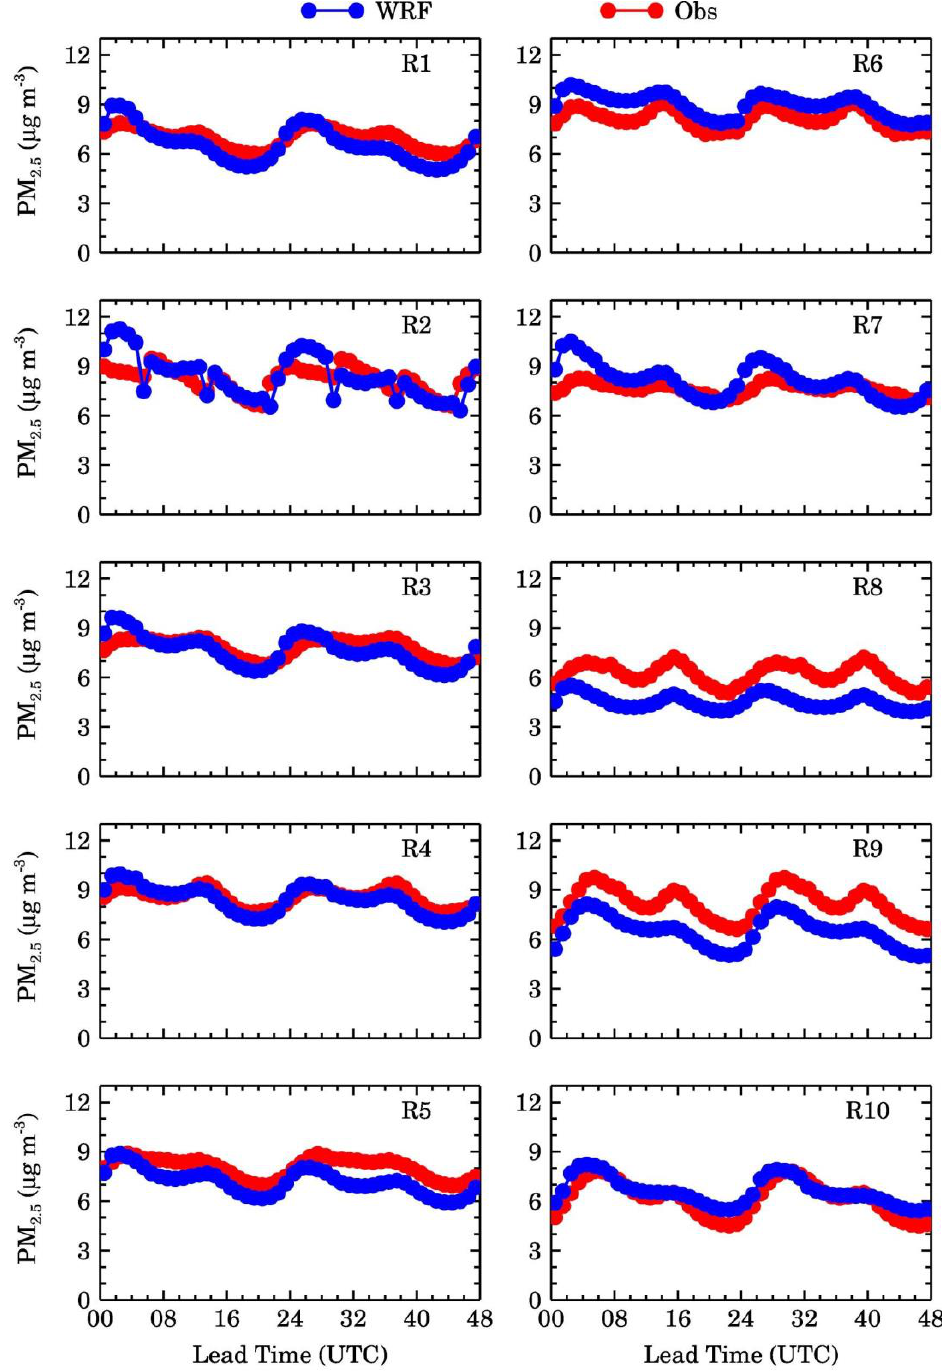
Figure 11. Verification of hourly averaged PM 2.5 forecasts over 10 EPA regions obtained by averaging PM 2.5 values at all Scheme 1 June 2019 to 31 May 2020, is used to calculate average PM 2.5 mass concentrations shown